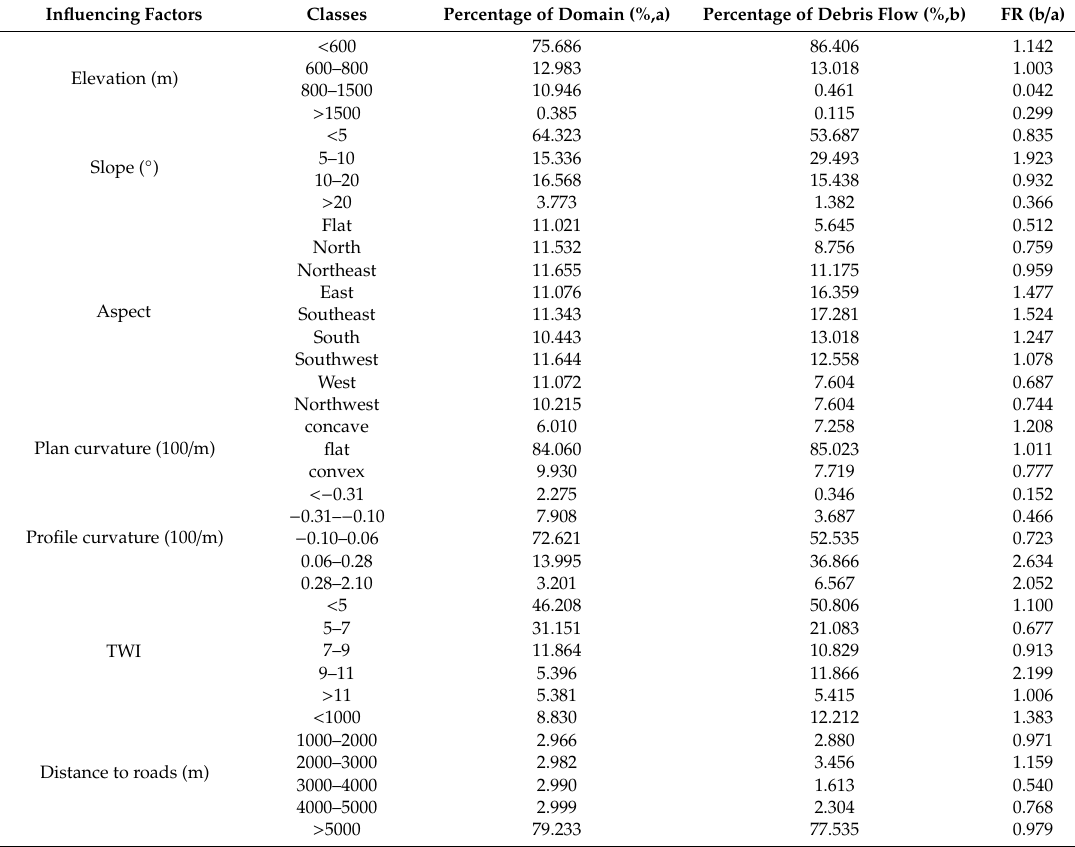
Table 5. The spatial relationship between influencing factors and debris flows by the frequency ratio (FR)